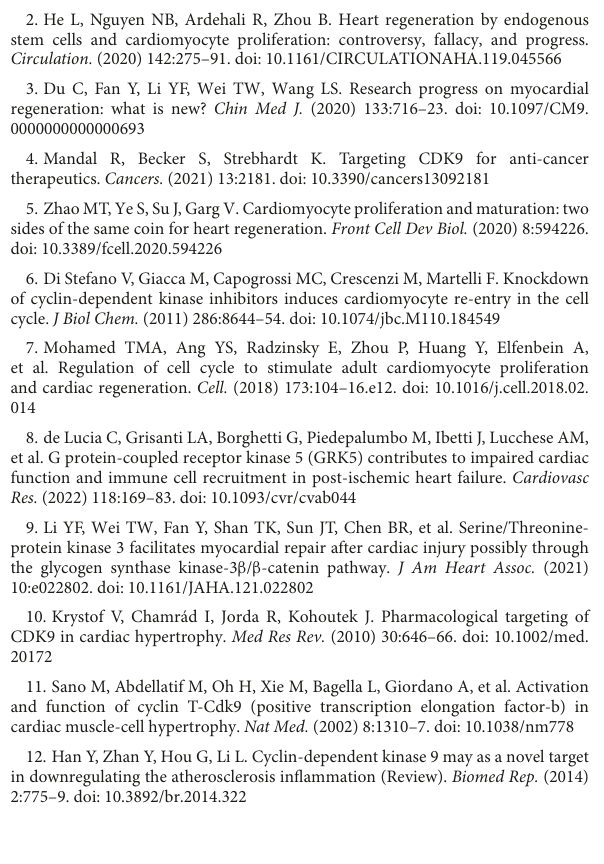
SUPPLEMENTARYFIGURE1 A Venn diagram describing proteins/peptides identified by pulldown-MS analysis from IgG and SGK3 group. SUPPLEMENTARYTABLE1 Details of proteins/peptides detected in IgG, SGK3, or both. SUPPLEMENTARYTABLE2 Descriptions of 26 SGK3-binded proteins and their biological